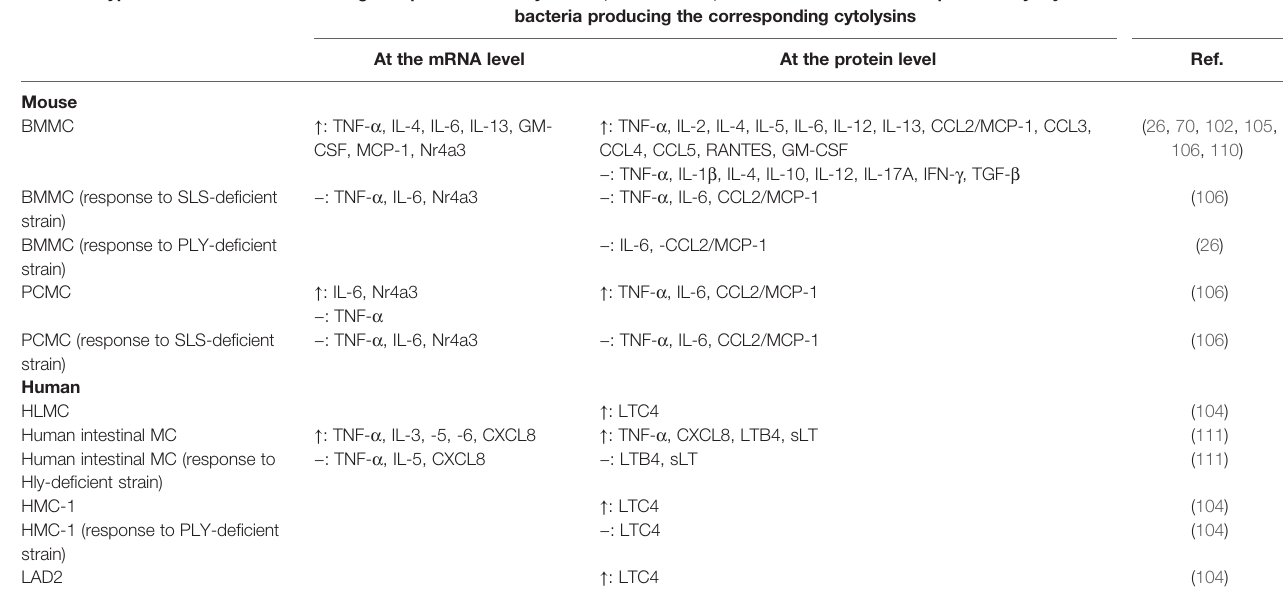
TABLE 3 | Effect of cytolysins or bacteria producing the corresponding cytolysins on production of selected cytokines, chemokines, and other mediators by various mast cell types. Mast cell type Changes in production of cytokines, chemokines, and other mediators in response to cytolysins or bacteria producing the corresponding cytolysins At the mRNA level At the protein level